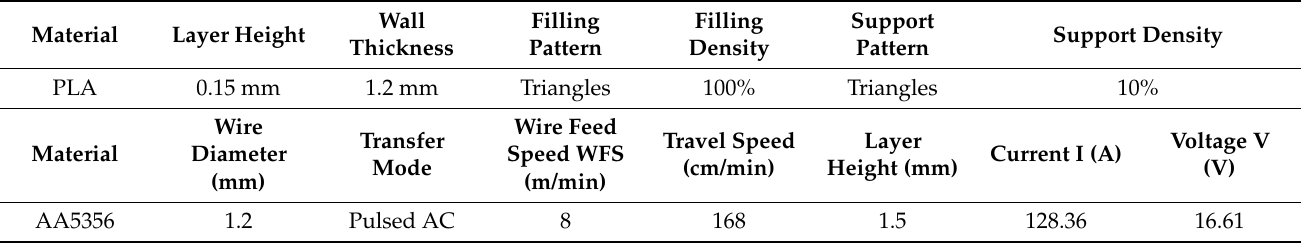
Table 2. Process parameters for FDM and WAAM.